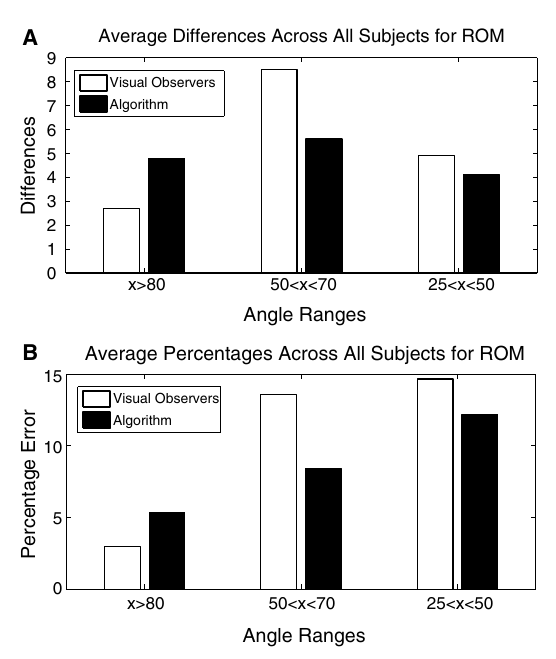
Fig. 11. Comparison between the expert users and algorithm, with respect to the ground truth data, of the averages across all subjects for the ROM data. (a) Average Differences. (b) Average Percentage Errors.